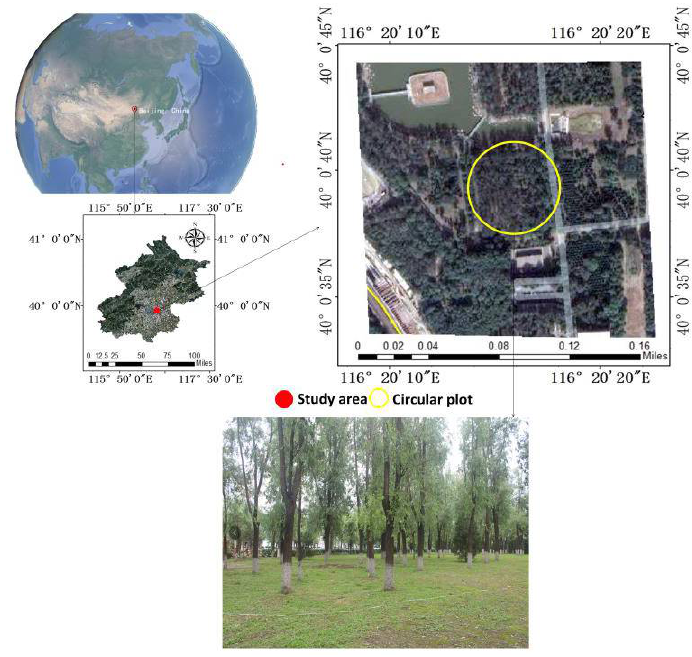
Figure 1. The circular plot location map and natural landscape of the study